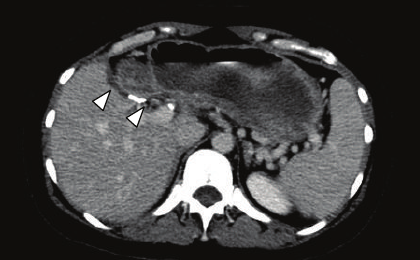
Figure 5: Computed tomography scan of the abdomen with intra- venous contrast for patient IS, two weeks following laparoscopic left hepatectomy. There is no evidence of a structural etiology for delayed gastric emptying, including adhesion formation between the stomach and cut liver surface (white